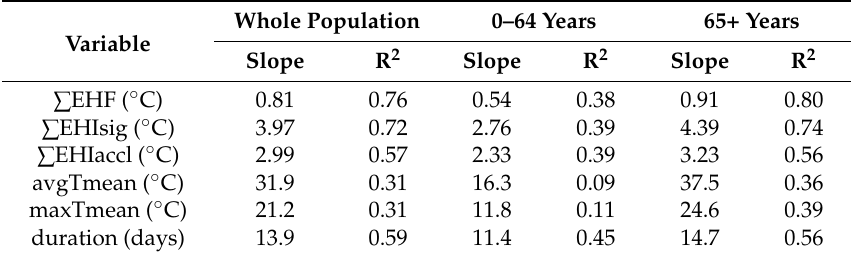
Figure 4. Relationship between cumulative excess mortality for the whole population and ( a ) cumulative excess heat factor ( ∑ EHF), ( b ) average daily mean temperature (average Tmean), ( c ) maximum daily mean temperature (maximum Tmean), and ( d ) duration of heat waves, during 1994–2015 in the Czech Republic. Dash-dotted lines indicate 95% confidence interval of the regression line. Slopes of the fitted regression lines are presented in Table 3. Table 3. Relationships of cumulative excess mortality for the whole population, the younger (0–64 years) and the elderly (65+ years) age groups to heat wave characteristics (independent variables x), namely cumulative excess heat factor ( ∑ EHF), cumulative significance index ( ∑ EHIsig), cumulative acclimatization index ( ∑ EHIaccl), average daily mean temperature (avgTmean), maximum daily mean temperature (maxTmean), and length of heat waves (duration). Regression coefficients are reported along with their associated R 2 . All relationships were statistically significant at p <